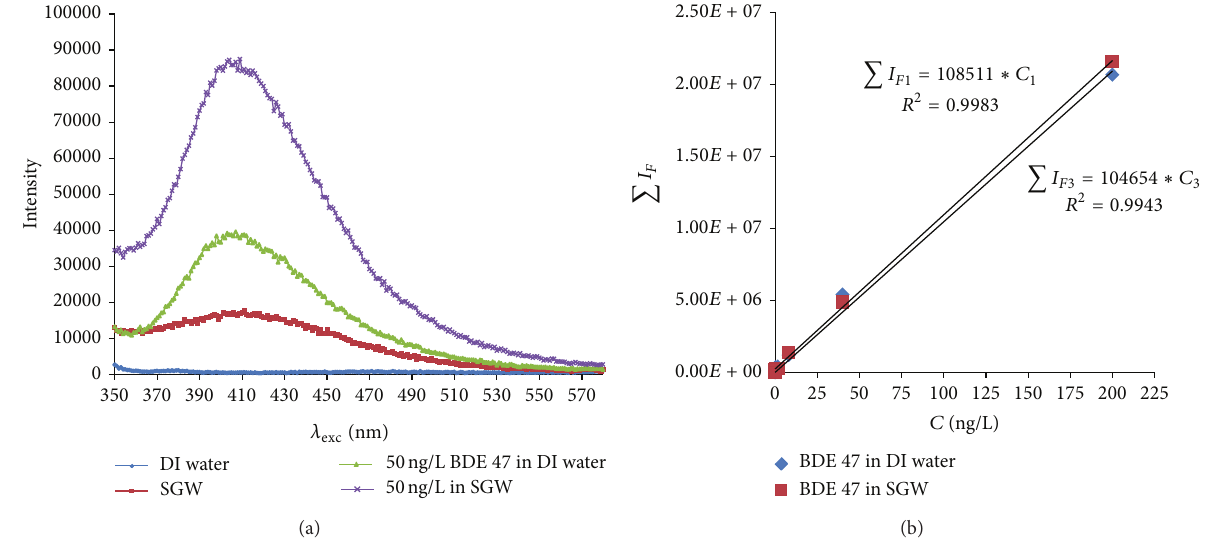
Figure 6: The effect of SGW on the fluorescence spectra of BDE 47 (a) and linear correlations between fluorescence intensity and BDE 47 concentrations